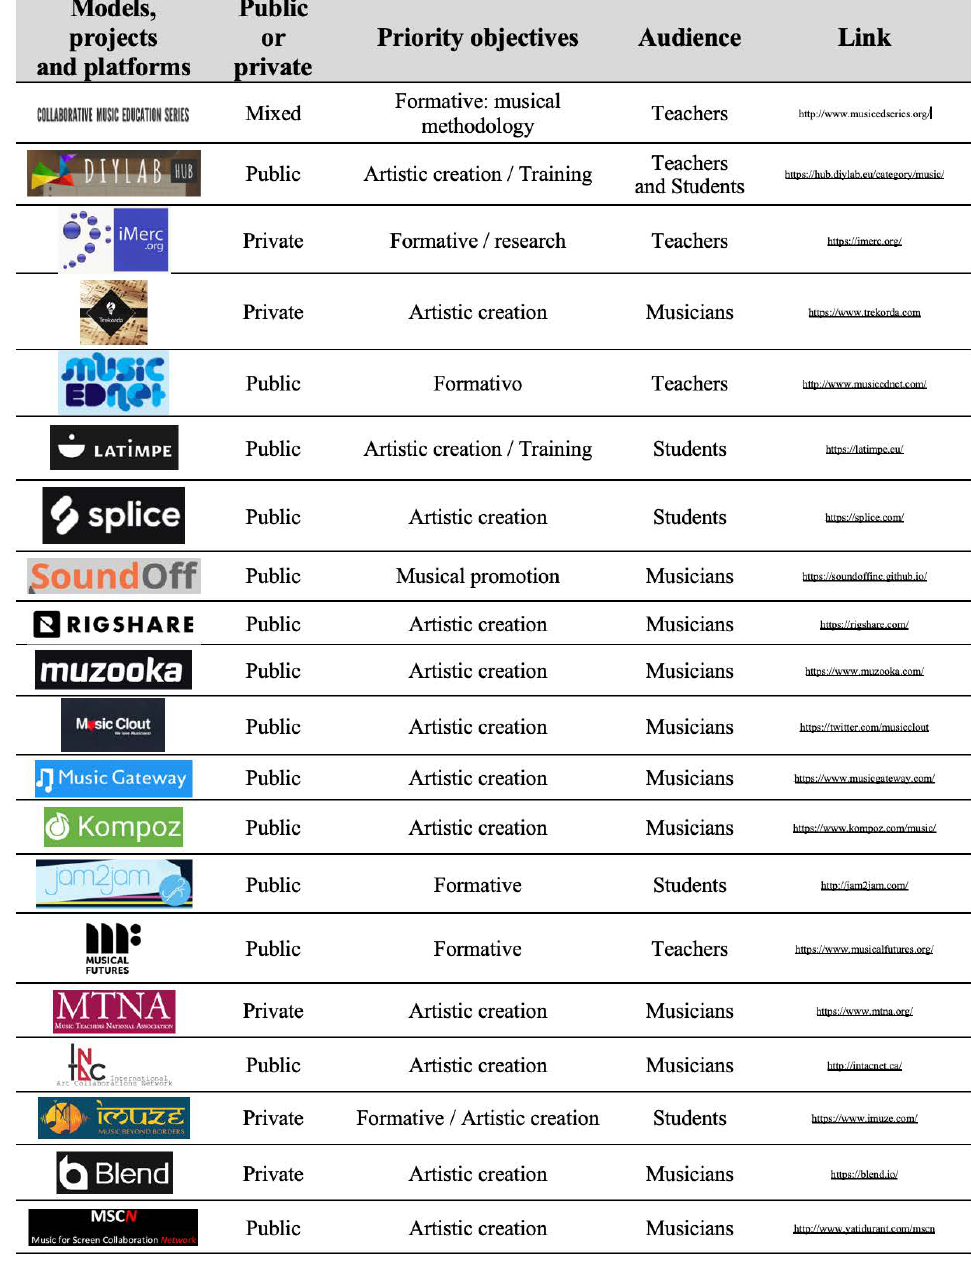
Table 1. Models, projects and platforms. Source: